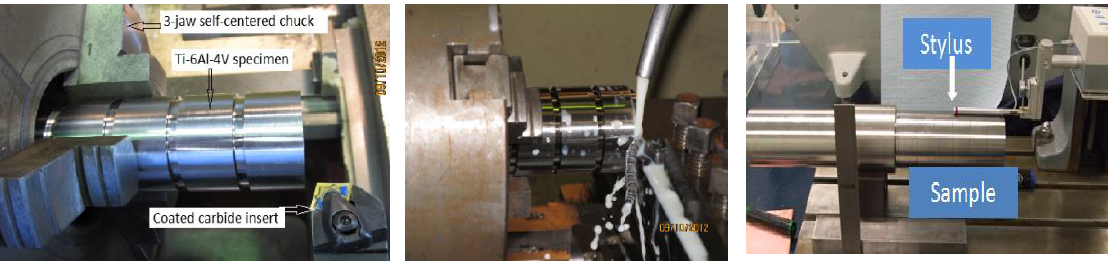
Figure 2: Surface roughness assessment using Surtronic 3+